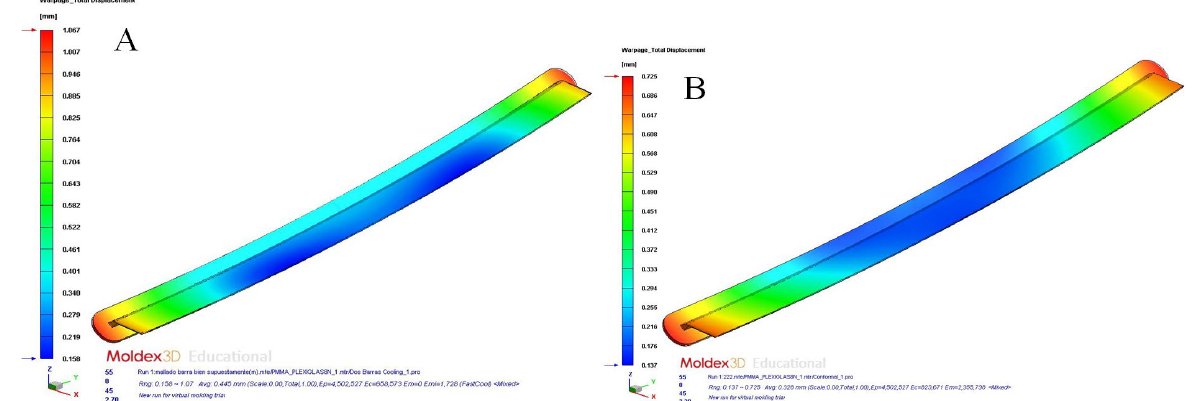
Figure 17. Total warpage (mm); straight drilled channels ( A ), conformal channels—Fastcool full bars ( B ).